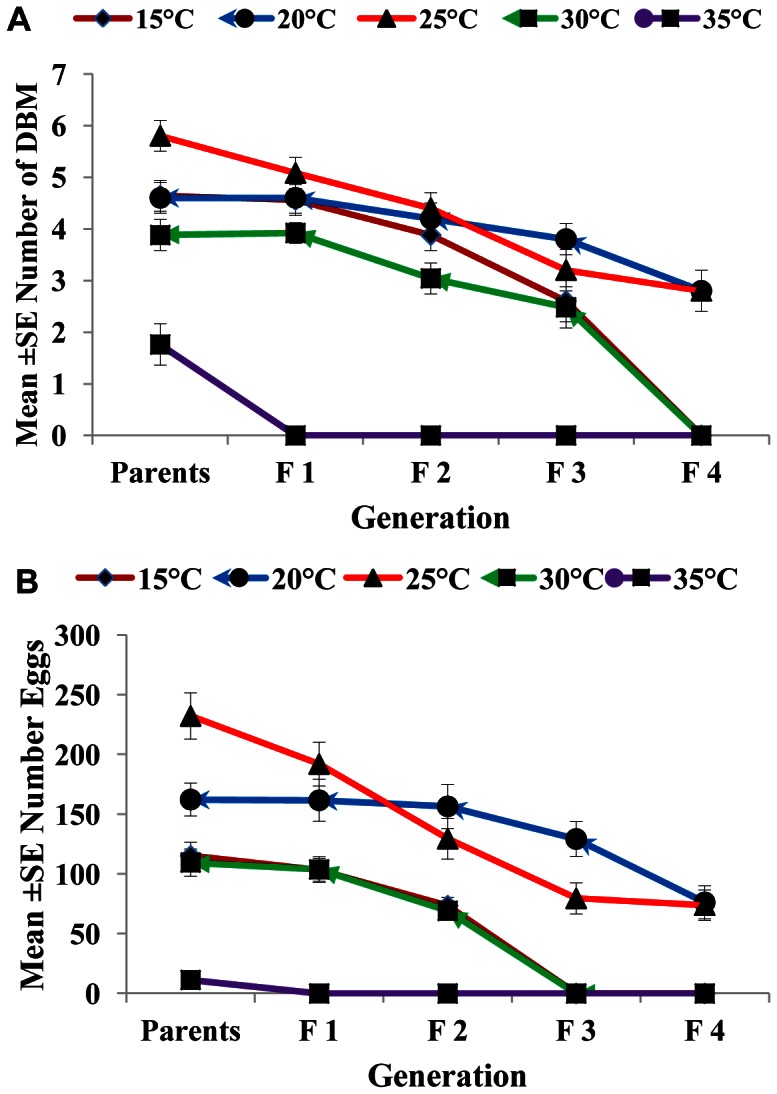
Influence of temperature on adult emergence and egg production of P. xylostella through successive generations.Data represent the mean ± SE of the number of adults emerged (a), number of eggs produced by DBM adults (b) developed from Nosema infected DBM larvae through successive generations. Vertical bars = S.E.